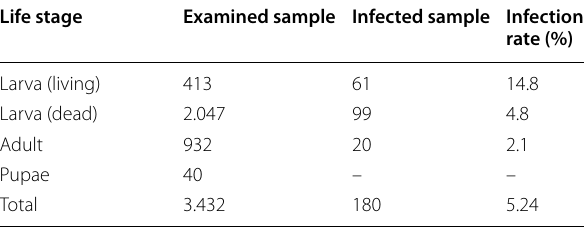
Table 2 Occurrence of Mattesia dispora in the different life stages of Plodia interpunctella Life